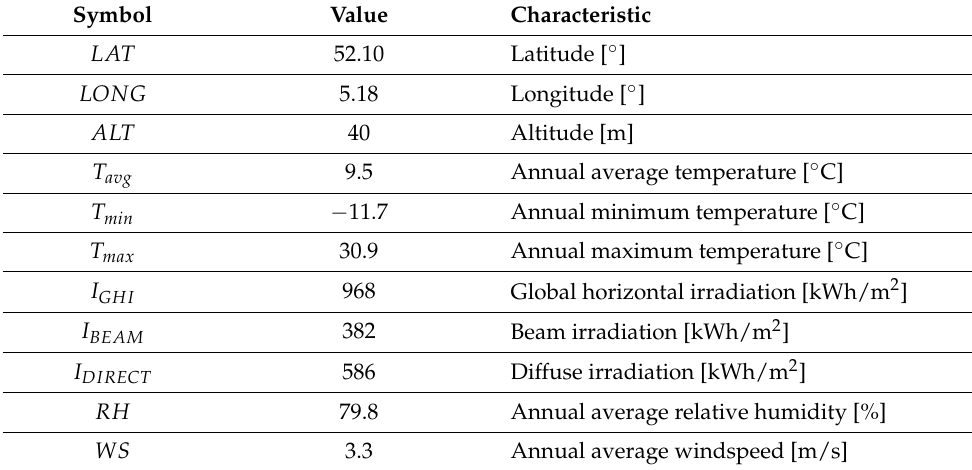
Table 2. Climate characteristics of the reference location.